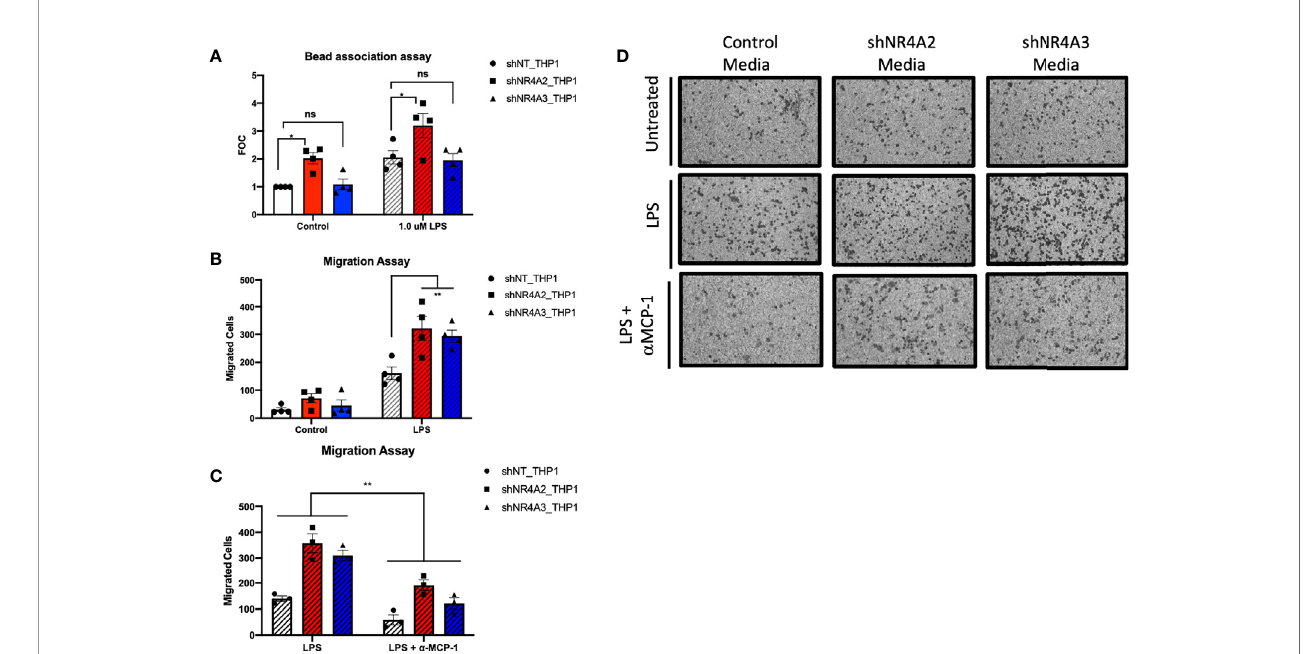
FIGURE 6 | Knockdown of NR4A2 but not NR4A3 increases bead association, while knockdown of either NR4A2 or NR4A3 increases cell migration. Knockdown of NR4A2 selectively promotes antigen presentation while cell migration is comparably enhanced by loss of NR4A2 or NR4A3. Fluorescent bead association assay in which shNT THP-1 cells, NR4A2 and NR4A3 depleted cells were treated +/-1 m g/ml LPS for 2hrs followed by addition of 1 m m fl uorescent beads source for a further 2hrs. Fluorescence was measured at 535/575 nm. Results expressed as fold over control (FOC) (unstimulated shNT-THP-1) for n= 4 independent experiments (A) . Cell migration assay in which shNT-THP-1 cells were exposed for 2hrs to conditioned media from shNT-THP1, NR4A2 and NR4A3 depleted cells +/- 100ng/ml LPS (22hrs). Results expressed as migrated cells for n=4 independent experiments (B) . Cell migration assay in which shNT-THP-1 cells were exposed for 2hrs to conditioned media from shNT-THP1, NR4A2 and NR4A3 depleted cells + 100ng/ml LPS (22hrs). Prior to migration assay conditioned media was treated +/- an anti-MCP1 neutralising antibody (2ng/ml) for approximately 1hr. Results expressed as migrated cells for n=3 independent experiments (C) . Note data from non-antibody treated media is also included as part of (B) Representative images (10X magni fi cation) of migrated cells +/- LPS, +/- anti-MCP-1 fi xed to transwell inserts shown in (D) . Statistical analysis (A, B & C) was performed using 2-way ANOVA (assuming sphericity) followed by Sidak ’ s multiple comparisons test (A&B). **p</= 0.01; ns, p >